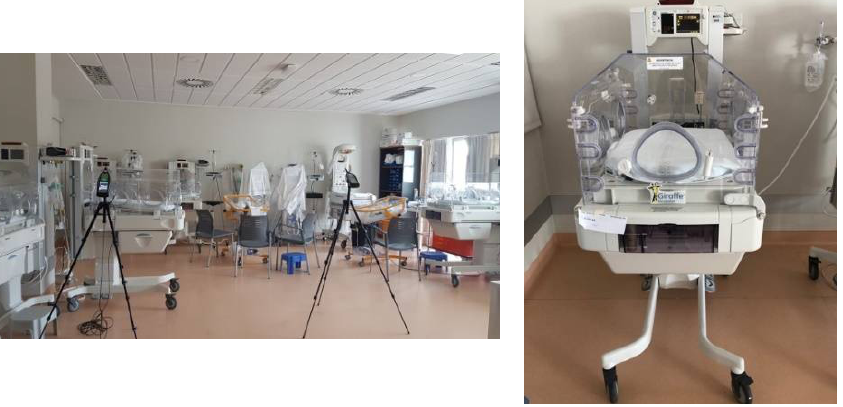
Figure 1. Neonatal ward of the Francesc de Borja Hospital in Gandía. Neonatal incubator.